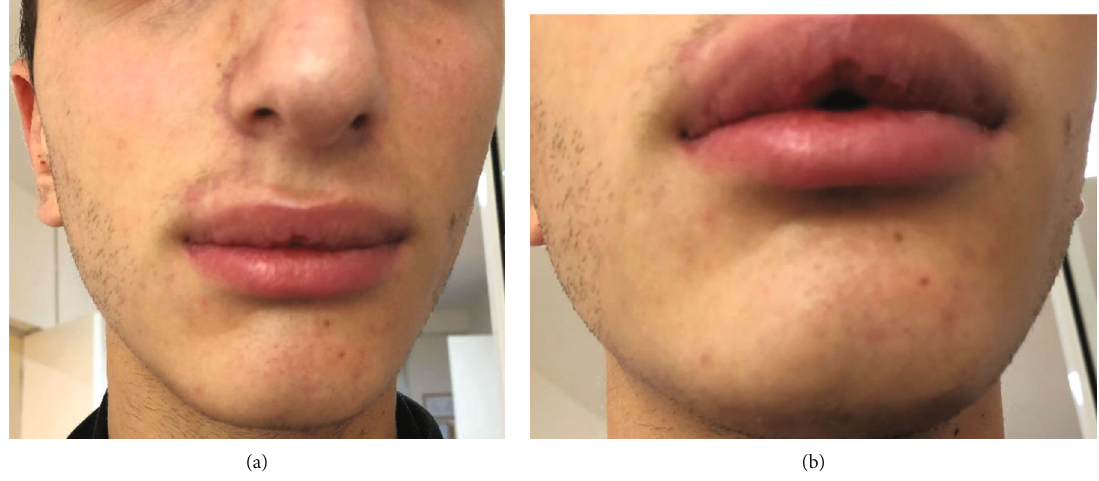
Figure 1: (a, b) Signi fi cant swelling of the upper and lower lips.